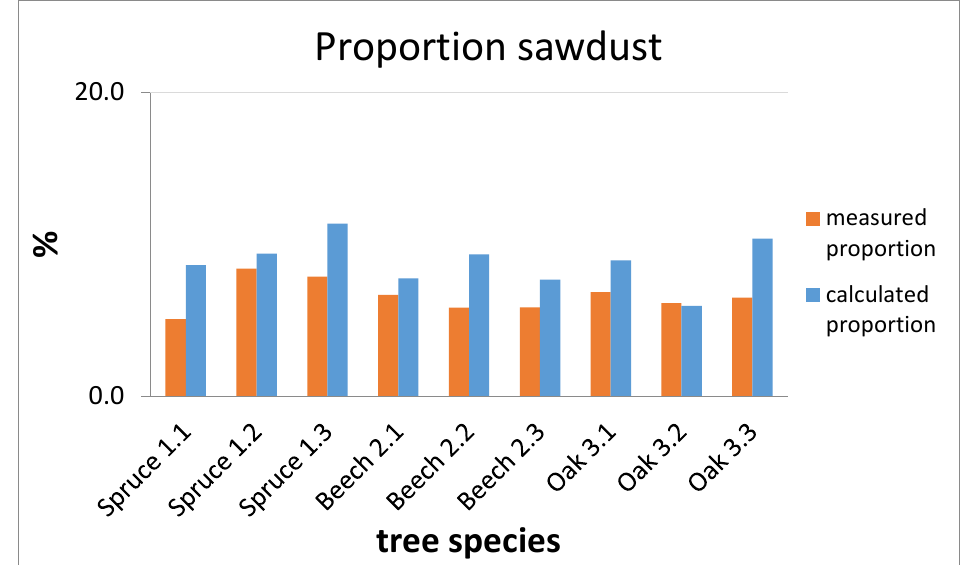
Figure 15. Graphical comparison of the measured and calculated proportion of sawdust produced from the cutting pattern implementation.